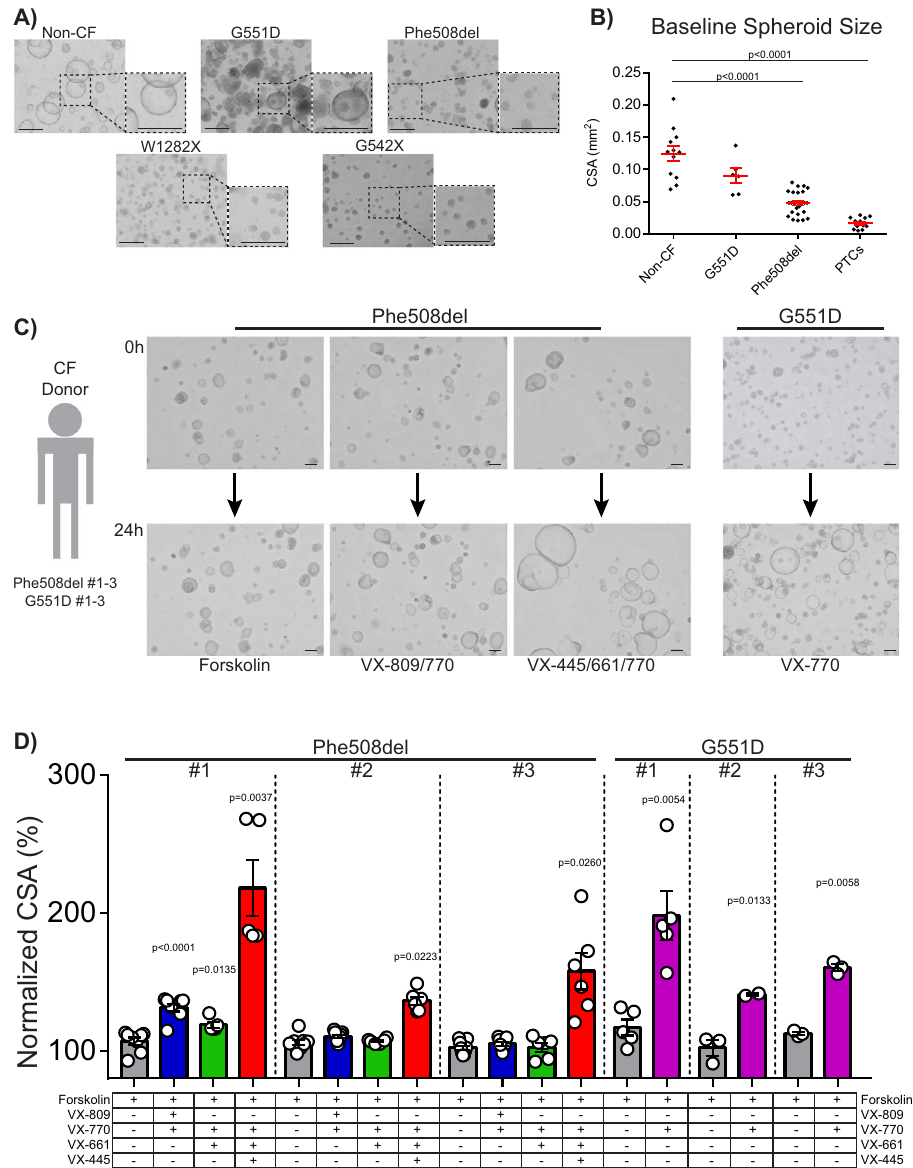
Fig. 3 Characterization of CF iPSC-derived airway epithelial spheroids in terms of morphology, size, and FIS with and without CFTR modulator treatment. A Representative microscopy images (of n ≥ 3 biological replicates from independent differentiations for each cell line) of airway spheroids from CF and non-CF donors demonstrate differences in morphologic appearance; dashed boxes depict magni fi ed views. B Baseline spheroid size differs with CFTR genotype. Each point represents average spheroid size before forskolin stimulation within an individual experiment (biological replicates from independent differentiations: n = 12 for non-CF, n = 6 for G551D, n = 26 for Phe508del, n = 12 for PTCs). C Representative spheroid images (of n > 3 biological replicates from independent differentiations for each cell line) for the CFTR variants indicated before (0 h) and after (24 h) treatment with compounds shown at bottom of panel. D Change in CSA after treatment of CF airway epithelial cell spheroids with CFTR modulators ( n > 3 biological replicates from independent differentiations with exception of n = 2 for G551D #2 VX-770 treatment). P values were calculated using paired two-tailed Student ’ s t test comparing the treatment sample to forskolin control. Scale bars represent 250 µ m. Lines and error bars represent mean ± standard